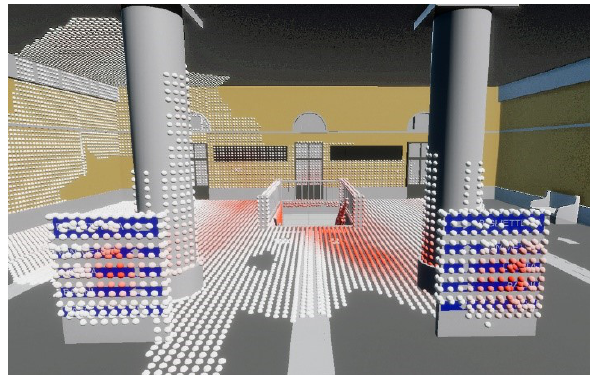
Figure 7. Three-dimensional representation of the results.